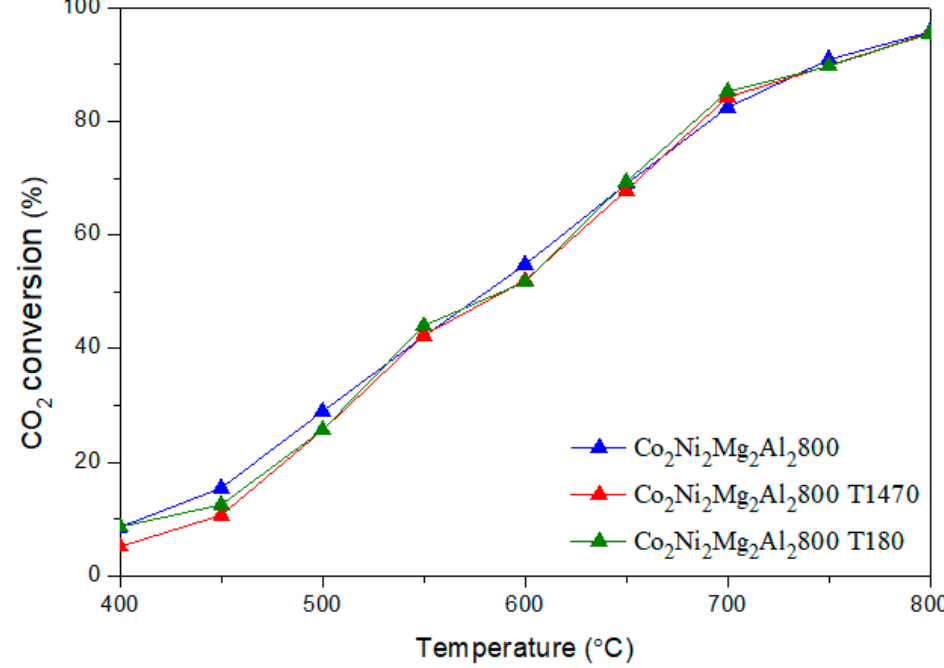
Figure 7. Evolution of the CO 2 conversion in DRM versus reaction temperature on the catalyst Co 2 Ni 2 Mg 2 Al 2 800 with and without toluene.